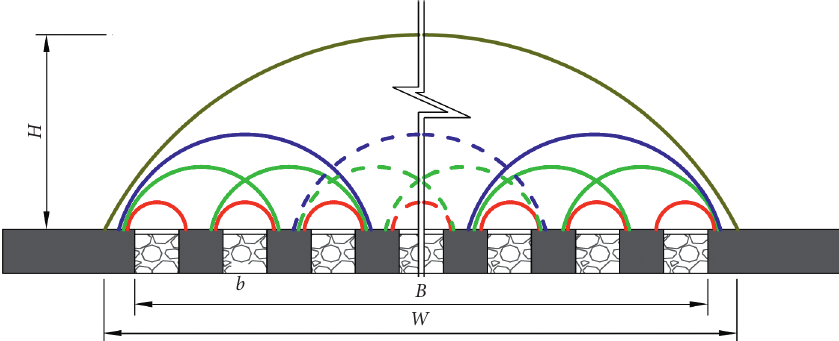
Figure 4: Schematic diagram of expansive pressure arch theory.